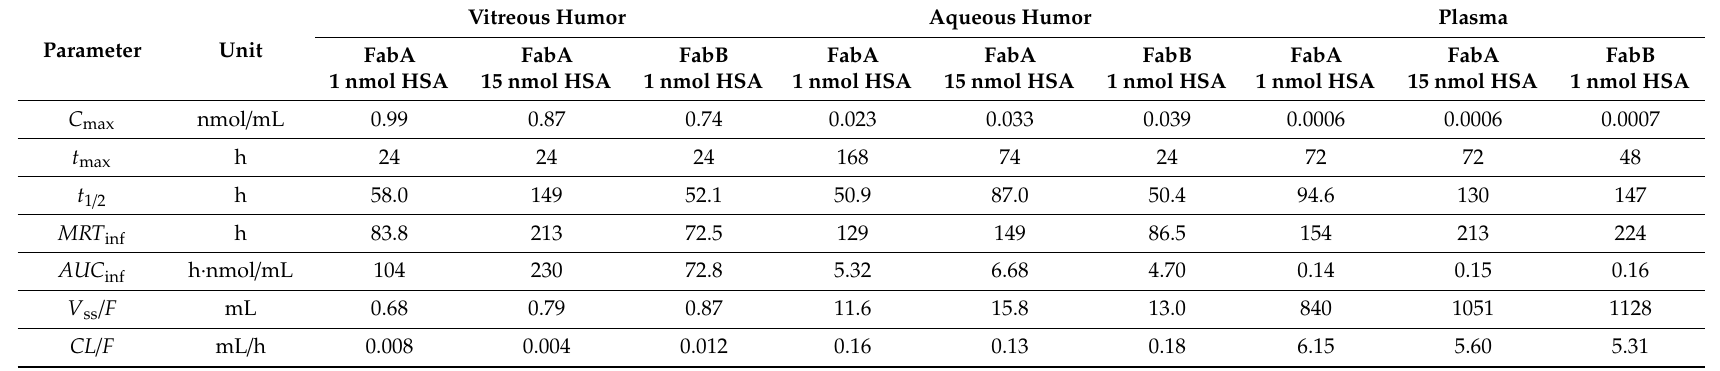
Table 5. Pharmacokinetic parameters calculated for FabA and FabB in rabbit VH, AH and plasma after a single IVT injection of 0.05 mg of the respective molecule co-administered with 1 nmol (FabA and FabB) and 15 nmol HSA (FabA). The parameters were computed by non-compartmental analysis of composite profiles, assuming extravascular (plasma and AH) or intravenous (VH)